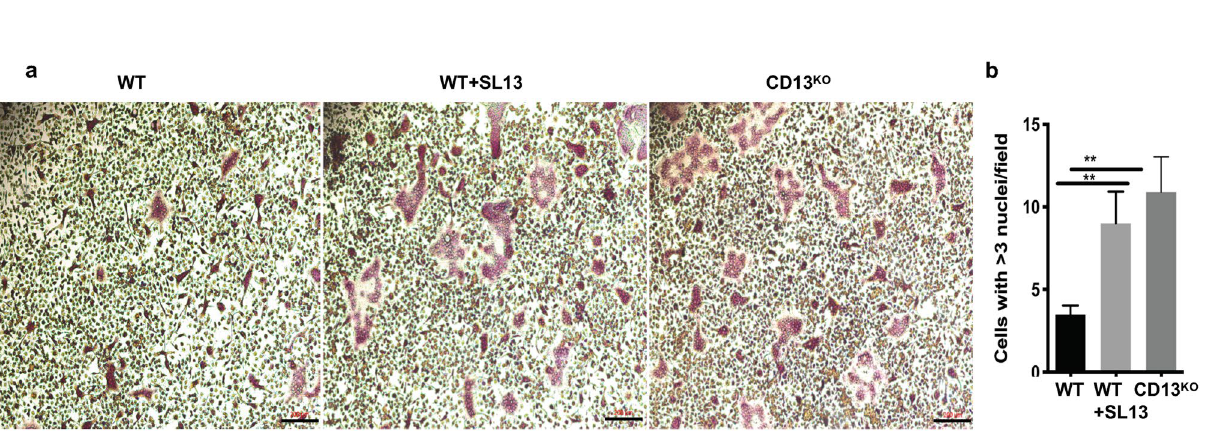
Figure 4. Treatment with CD13 blocking Ab leads to increased multinucleated OC formation in WT cells. ( a ). TRAP staining of WT, WT + SL13 and CD13 KO BM-derived osteoclast progenitor cells grown in presence of M-CSF and RANKL after 5d on plastic are shown in “red” color. ( b ). Quantification of Trap + OC with > 3 nuclei/ cell. TRAP + osteoclasts were imaged with Zeiss fluorescence inverted microscope and analyzed by using Zeiss Zen 2.0 Pro blue edition software (https:// www. zeiss. com/ conte nt/ dam/ Micro scopy/ Downl oads/ Pdf/ FAQs/ zen2- blue- editi on_ insta llati on- guide. pdf). Scale bar; 200 µm. Data represents ± SEM of three independent experiments. N = 3/genotype, **p < 0.01. Magnification